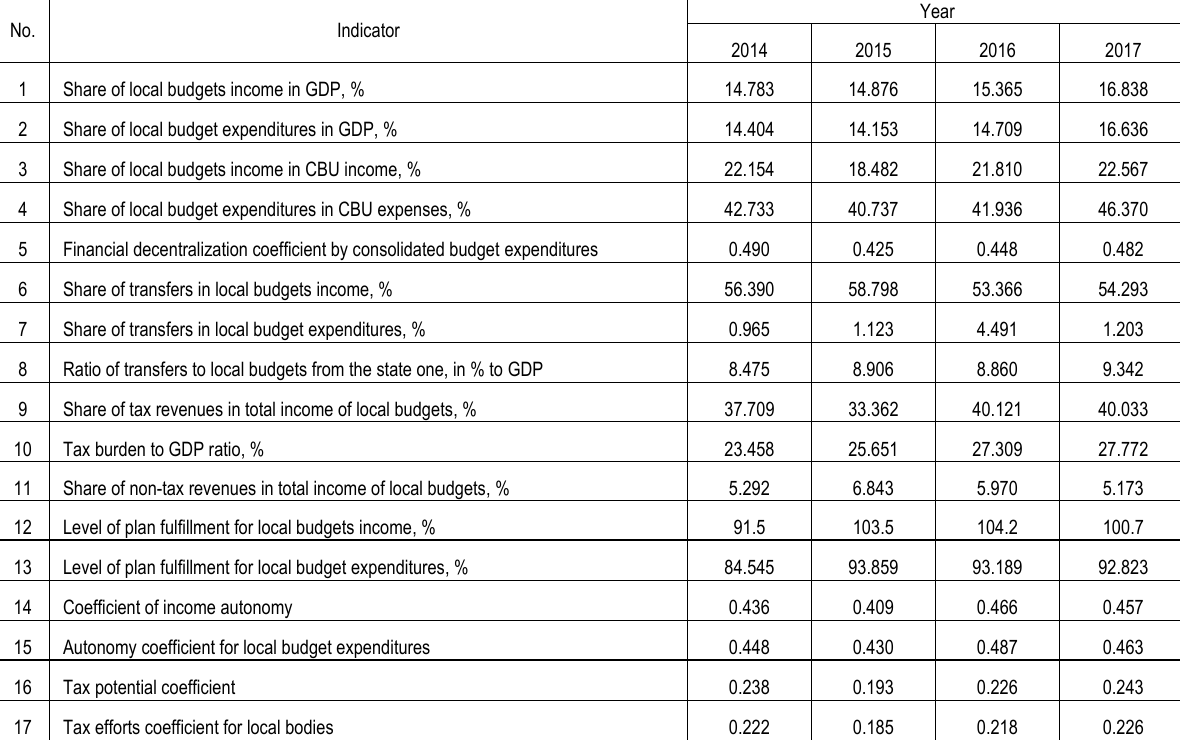
Table 1. Indicators of financial decentralization in Ukraine for 2014 – 2017